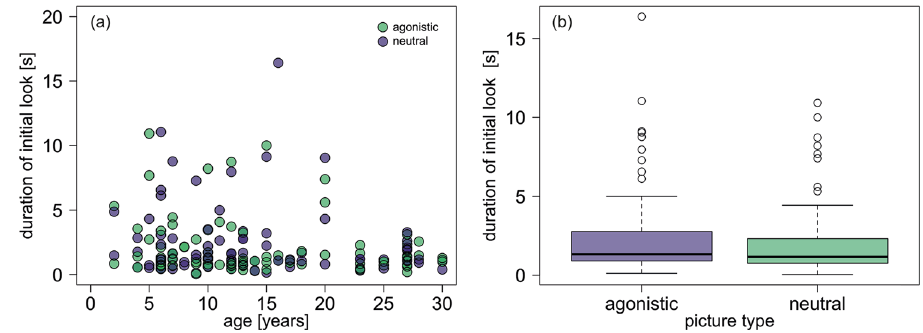
Fig. 4 Time spent looking at agonistic and neutral pictures in relation to age and condition. a Initial looking time in relation to age and picture type (violet = agonistic; green = neutral). b Initial looking time in relation to picture type (agonistic, neutral). Boxplots with median and interquartile range based on 166 trials with 45 subjects. Whiskers show values within 1.5 times the interquartile range. Dots indicate